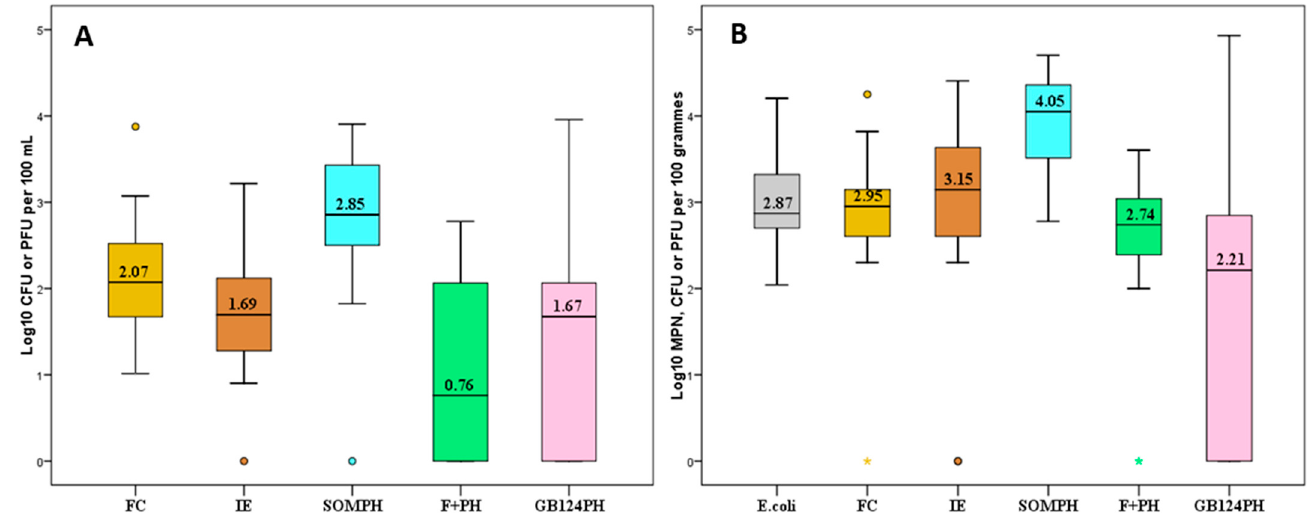
Figure 1. Box plots of faecal indicator concentrations in overlying waters ( A ) and in mussel flesh and intravalvular liquid matrices ( B ) ( n = 24). Values beneath the detection limits were assigned a value of zero. Those samples presenting 0 Plaque Forming Units (PFU), or Colony Forming Units (CFU) per 100 mL or 100 g were transformed to log10 (+1) PFU, or CFU per 100 mL or 100 g. (FC: faecal coliforms; IE: intestinal enterococci; SOMPH: somatic coliphages; F + PH: F-specific RNA phages; GB124PH: Bacteroides fragilis GB-124 phages). Coloured circles represent mild outliers; stars (*) represent extreme outliers.